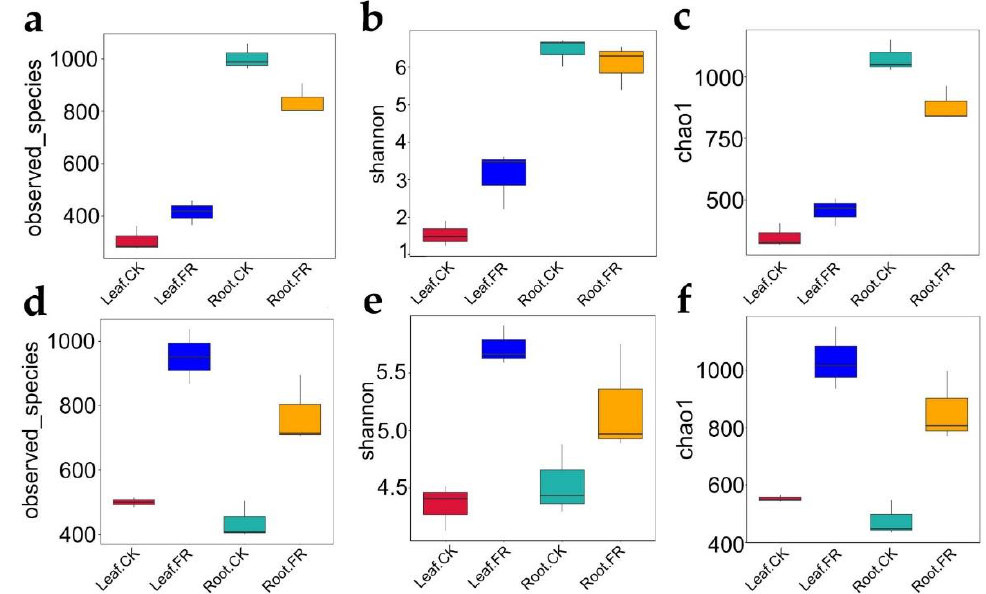
Figure 3. Boxplot showing the alpha diversity indices of the endophytic bacteria and fungi in the LC of FR and CK zones of LM fairy rings. Observed species index of ( a ) bacteria and ( d ) fungi. Shannon index of ( b ) bacteria and ( e ) fungi. Chao1 index of ( c ) bacteria and ( f ) fungi. All indices were calculated based on OTU. The top and bottom whiskers of boxes represent the maximum and minimum values; the line inside the box represents the median, the top margin of the box represents the upper quartile, and the lower margin of the box represents the lower quartile.